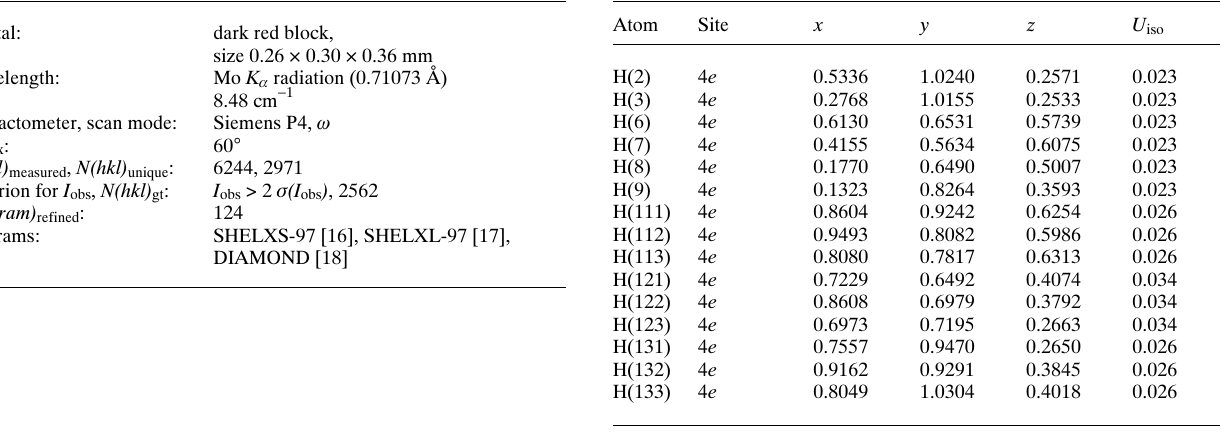
Table 2. Atomic coordinates and displacement parameters (in Å 2 ) . Table 1. Datacollection and